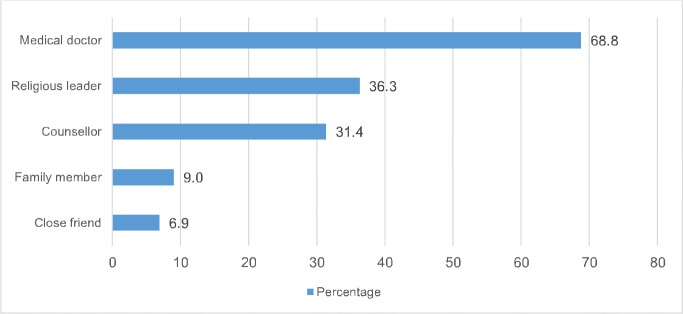
Person from whom respondents will seek support (n = 1,406).Note: Percentages are weighted and the total may sum up to more than 100% as multiple responses were permissible.